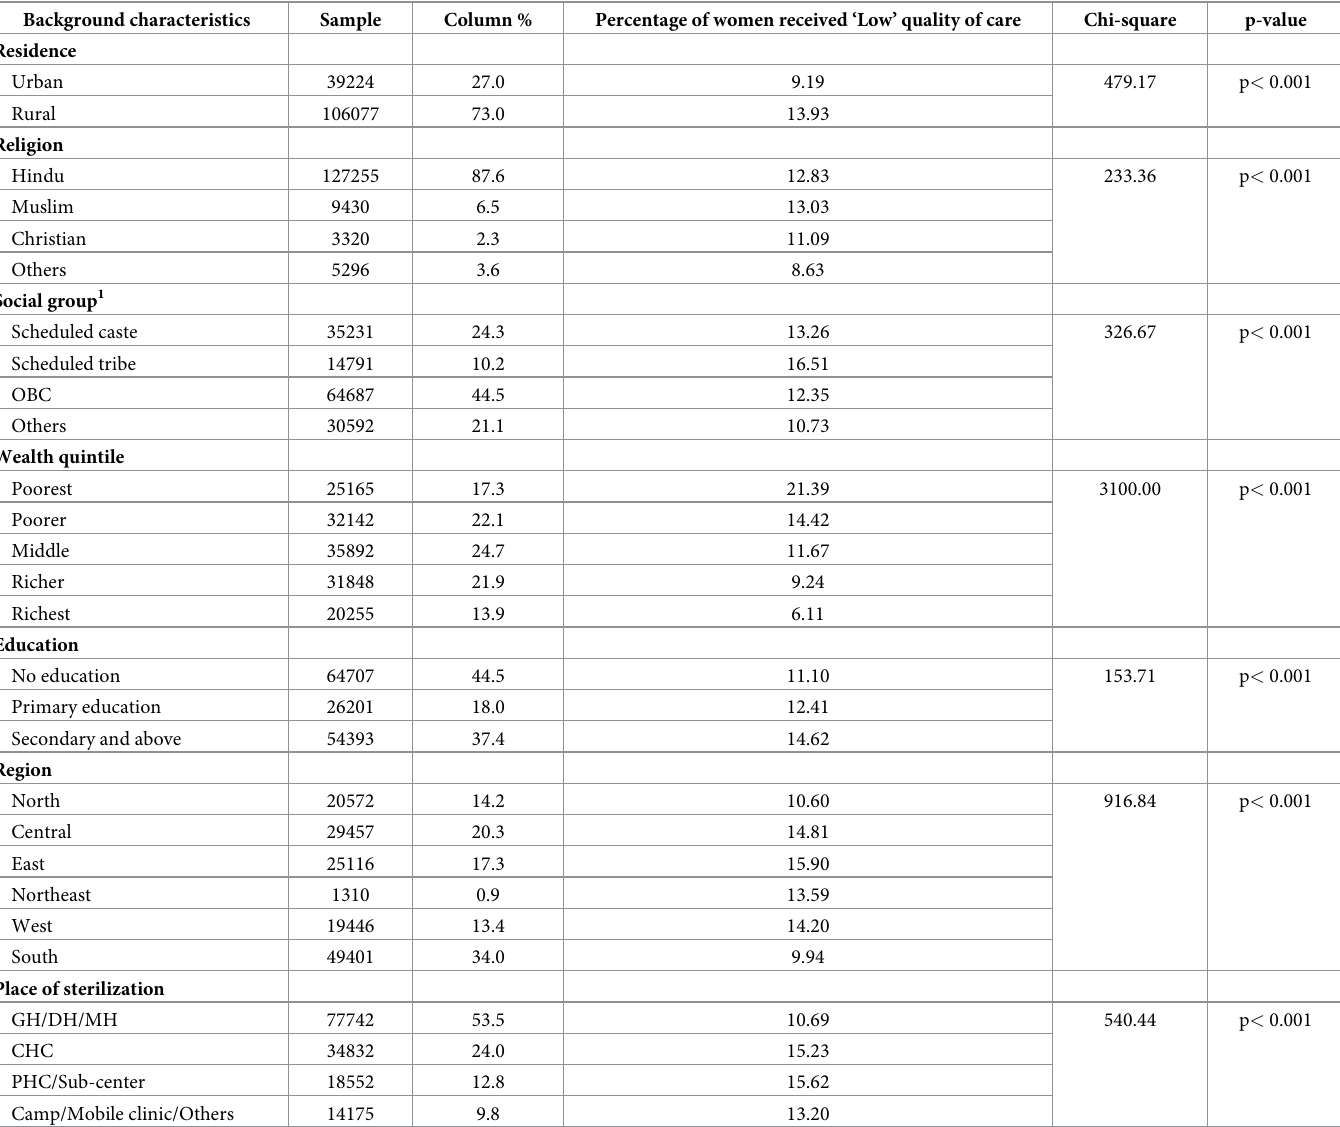
Table 1. Descriptive statistics, percentage distribution, and results of Pearson’s chi-square test for the quality of care in sterilization services in India. Background